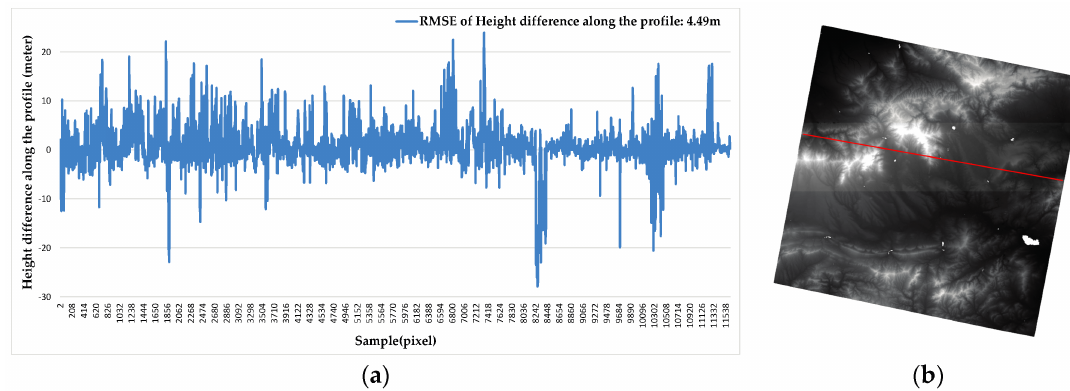
Figure 13. ( a ) The difference in the elevation profile between the reference DEM and DSM derived from ZY3-02; ( b ) location of the profile selection (red